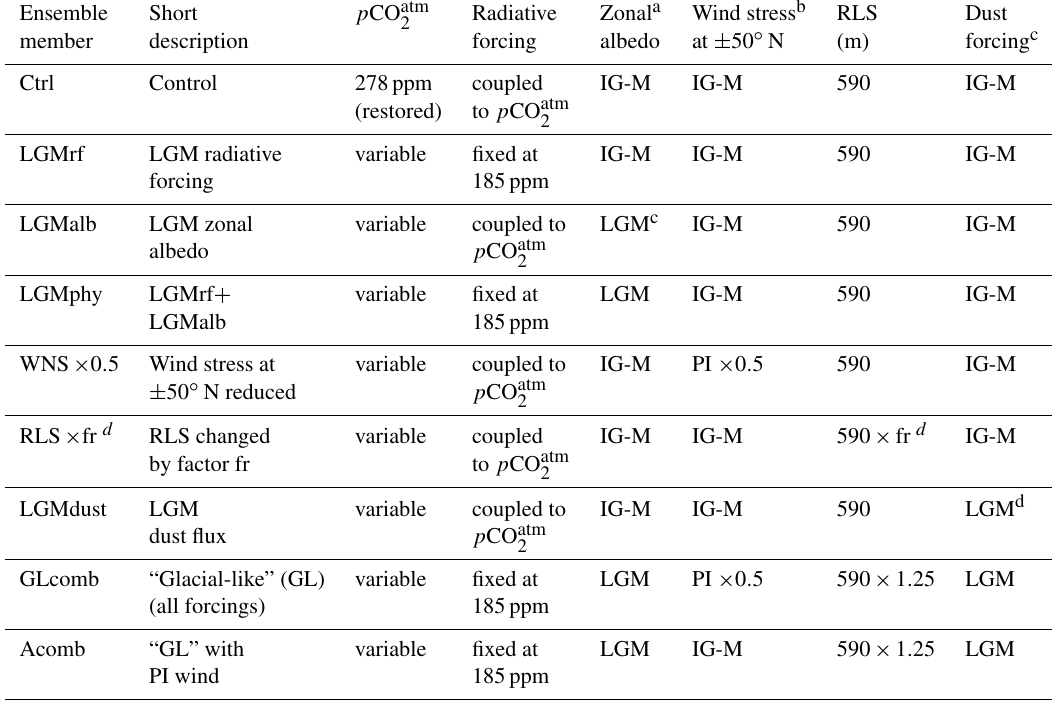
Table 1. List of experiments. Ensemble member acronyms, short descriptions of what the simulation tests, and specifications of parameter settings for each ensemble member. The p CO atm is either prescribed to pre-industrial level (PI) = 278ppm or freely varying with changes 2 in climate and ocean circulation. The radiative forcing is either coupled to the p CO atm of the atmospheric chemistry module of the model or 2 = 185ppm. The zonal albedo profile is either representative of IG-M conditions or of the LGM. fixed at a value corresponding to p CO atm 2 The wind stress is either IG-M or has an adjusted peak in wind stress at ± 50 ◦ N. The IG-M remineralization length scale (RLS) is 590m. If RLS is changed, it is multiplied by a factor (fr). Dust forcing is either IG-M or representative of LGM. Each experiment is conducted using model versions with C / P fixed at 106 / 1 (Redfield, 1963, denoted RED), C / P variable with surface ocean PO 4 concentration (Galbraith